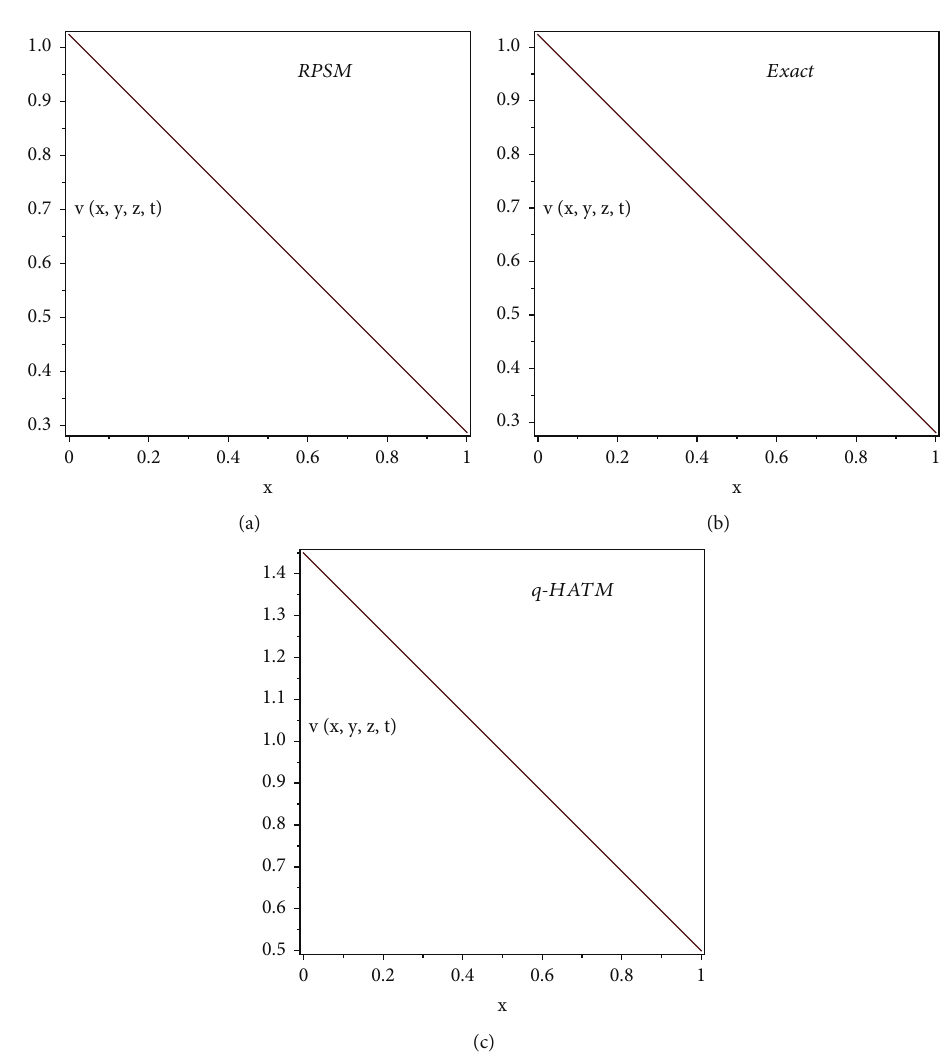
Figure 4: 2D-solutions plots of (a) RPSM, (b) Exact, and (c) q-HATM, at δ = 1 of Example